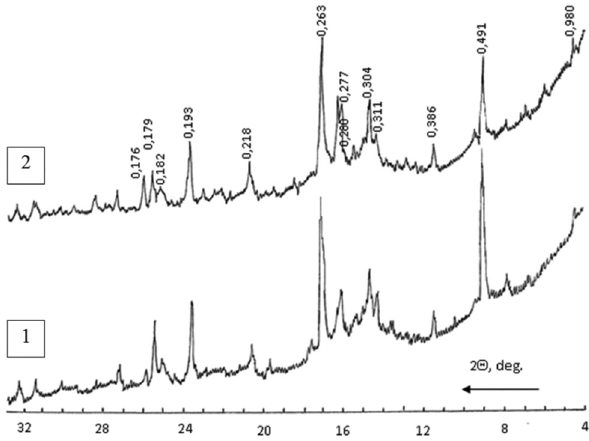
Figure 8: X - ray di ff raction patterns of cement paste samples: ( 1 ) CNTs are dispersed in PNS and ( 2 ) CNTs are dispersed in HMWOC.